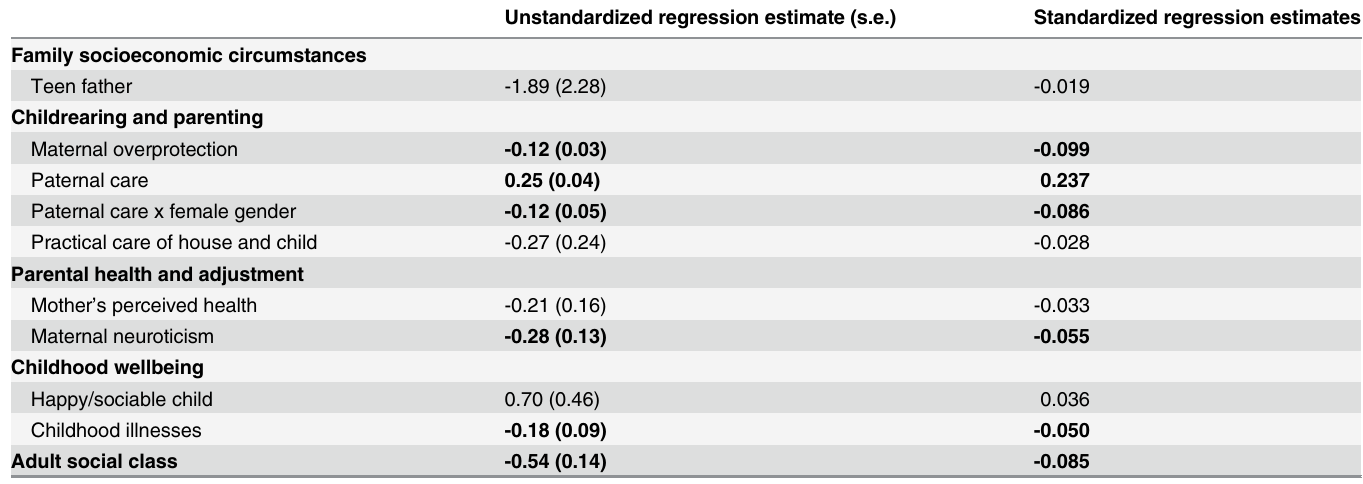
Table 3. Unstandardized and standardized fully adjusted model showing associations between Warwick-Edinburgh Mental Well-Being Scores and domains of socioeconomic and psychosocial circumstances in childhood. Unstandardized regression estimate